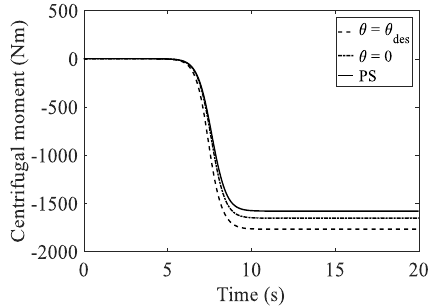
Figure 4. Time-domain response of the centrifugal moment of the vehicle.